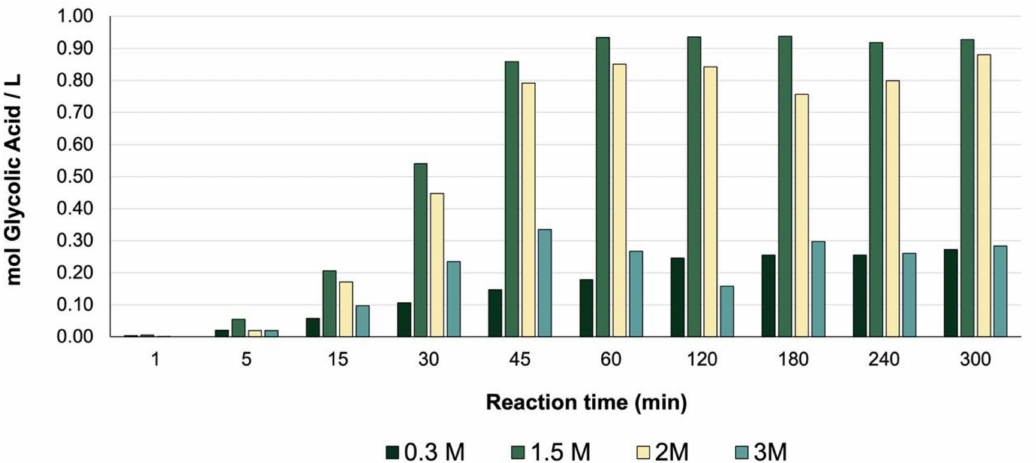
Figure 13. Concentration in the liquid product obtained by increasing the glycerol concentration at optimal operating conditions of temperature (60 ◦ C), NaOH/glycerol (2), O 2 /glycerol ratio (0.23), and catalyst/glycerol ratio